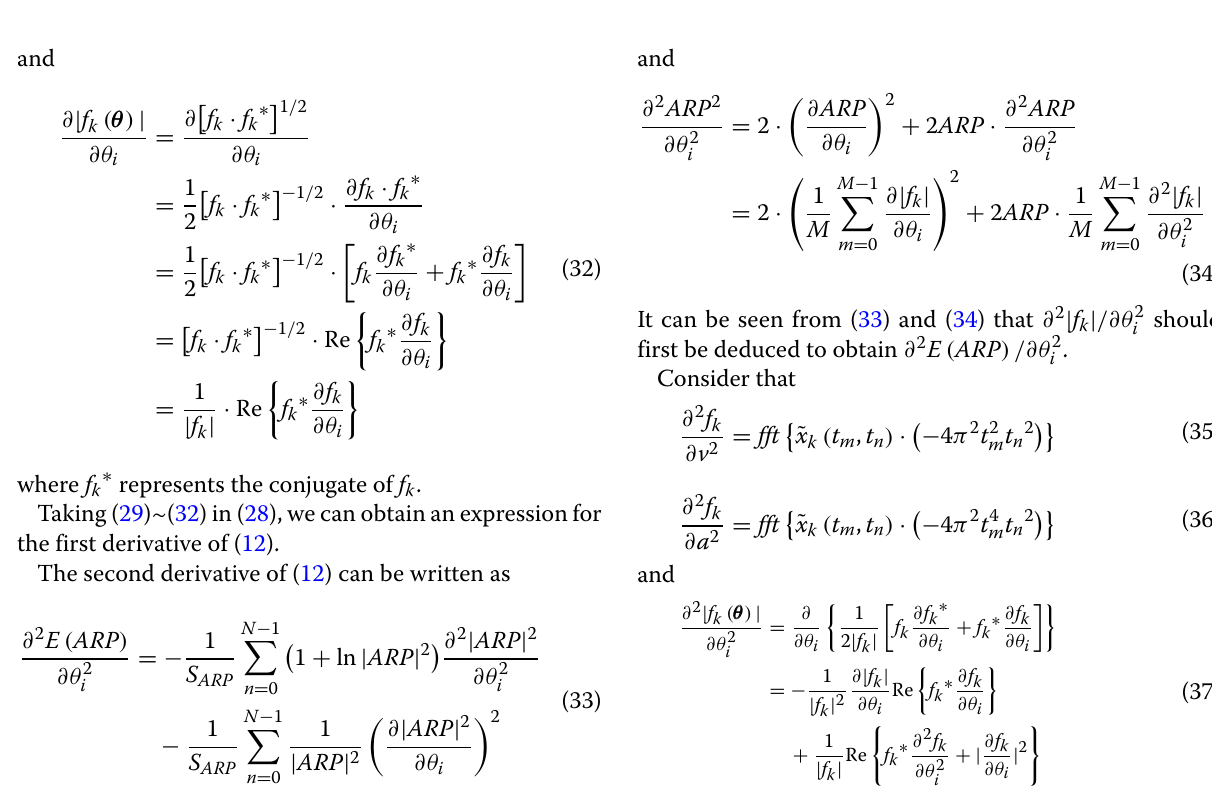
Fig. 15 Estimation results under a − 22 dB SNR. a The estimation result of the proposed algorithm, b the estimation result of the ACM, and c the estimation result of the